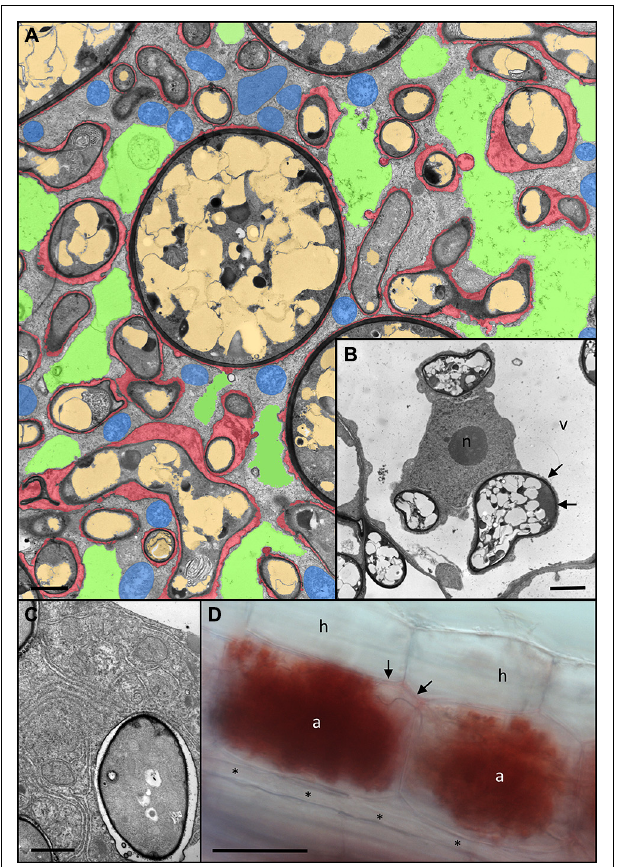
FIGURE 3 |Anatomy of Rhizophagus irregularis arbuscules and acidic nature of the periarbuscular space. (A) Cortex cell of Petunia hybrida colonized by a fully developed arbuscule with hyphal branches of variable diameters. Remnants of the fragmented central vacuole are colored green, plant mitochondria are blue, fungal vacuoles are light brown, and the periarbuscular space is red (modified from Bapaume and Reinhardt, 2012). (B) Host nucleus (n) of a colonized cell between three fungal hyphae. Note the close association of the fungus with the host cytoplasm resulting in no distinguishable periarbuscular space between the fungal wall (dark layer), and the thin cytoplasmic layer (arrows) between the fungus and the host vacuole (v). (C) Close up of an individual fungal fine branch of an arbuscule. The fine branch is embedded in organelle-rich host cytoplasm with endoplasmatic reticulum and plastids. (D) A pair of mature arbuscules (a) sharing a joined trunk hypha (arrows). Staining with Neutral Red reveals the acidic nature of the periarbuscular space, whereas the trunk hypha shows only weak staining, and a longitudinal intercellular hypha (asterisks) is completely devoid of staining. a, arbuscule; h, hypodermal cell; n, host nucleus; v, host vacuole. Size bar 2 μ m in (A,B) , 1 μ m in (C) , and 50 μ m in (D)